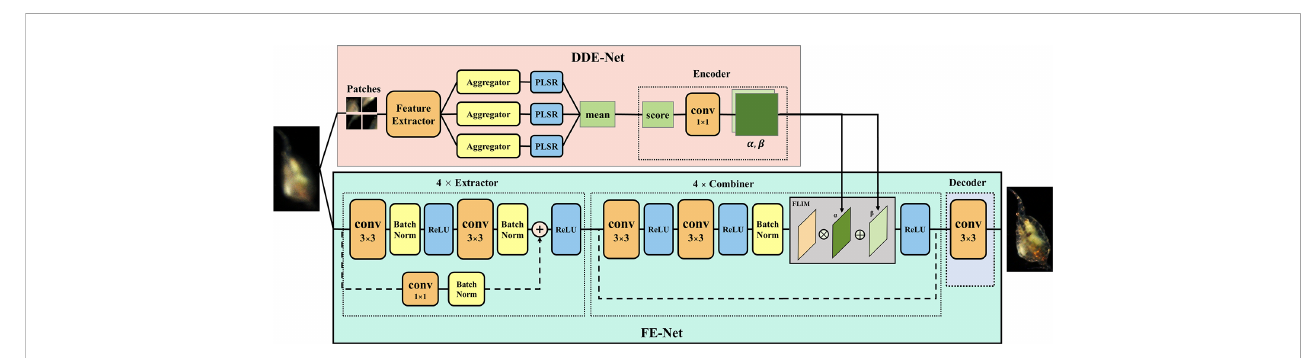
FIGURE 4 Schematic structure of the deep focus-extension network IsPlanktonFE.